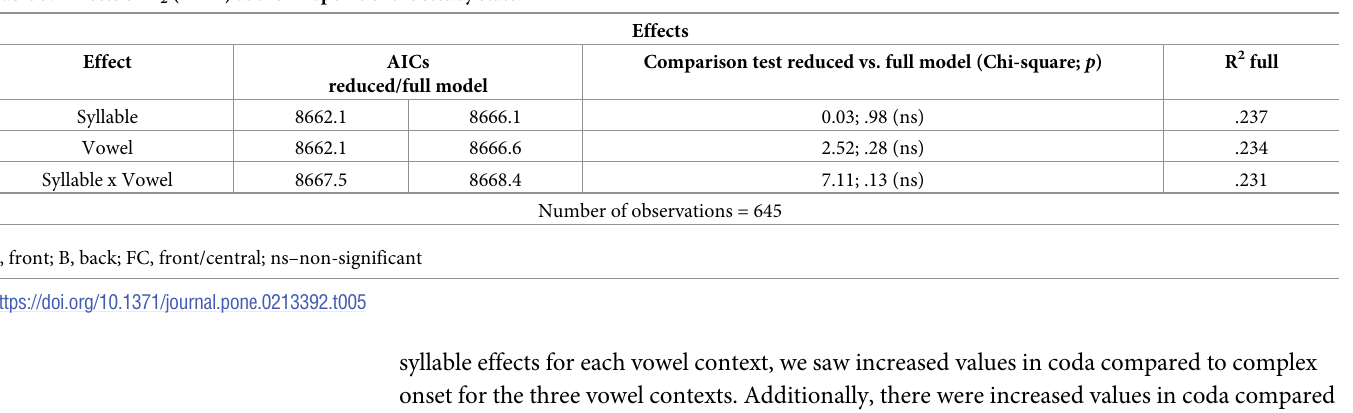
Table 6. Descriptive statistics for F